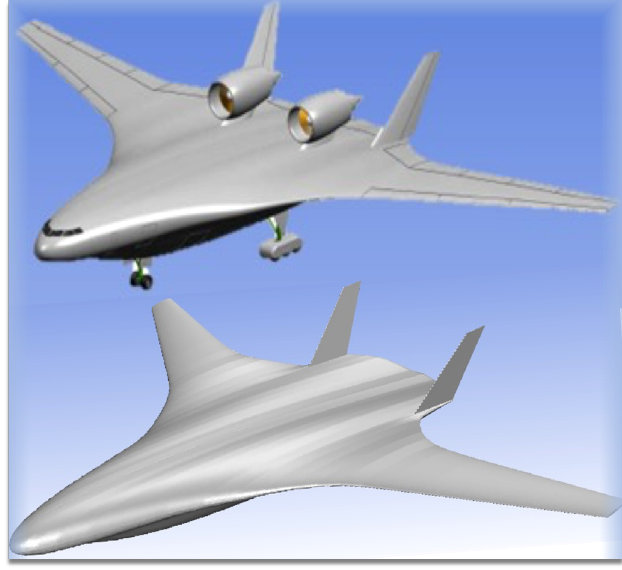
Figure 1. N2A aircraft aeroshape: realistic configuration ( up ); simulated configuration ( down